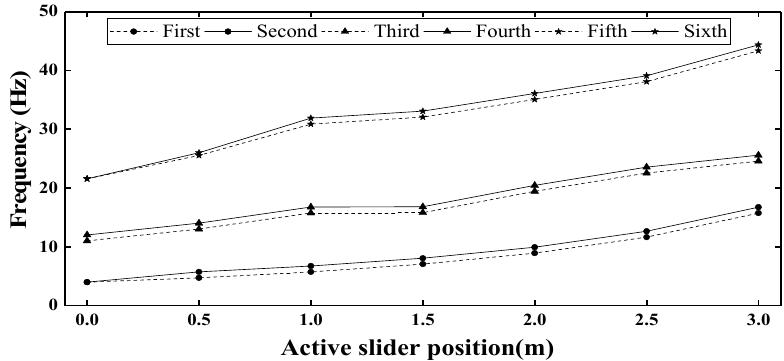
Figure 5. First six order natural frequency of the lead screw without the support slider.